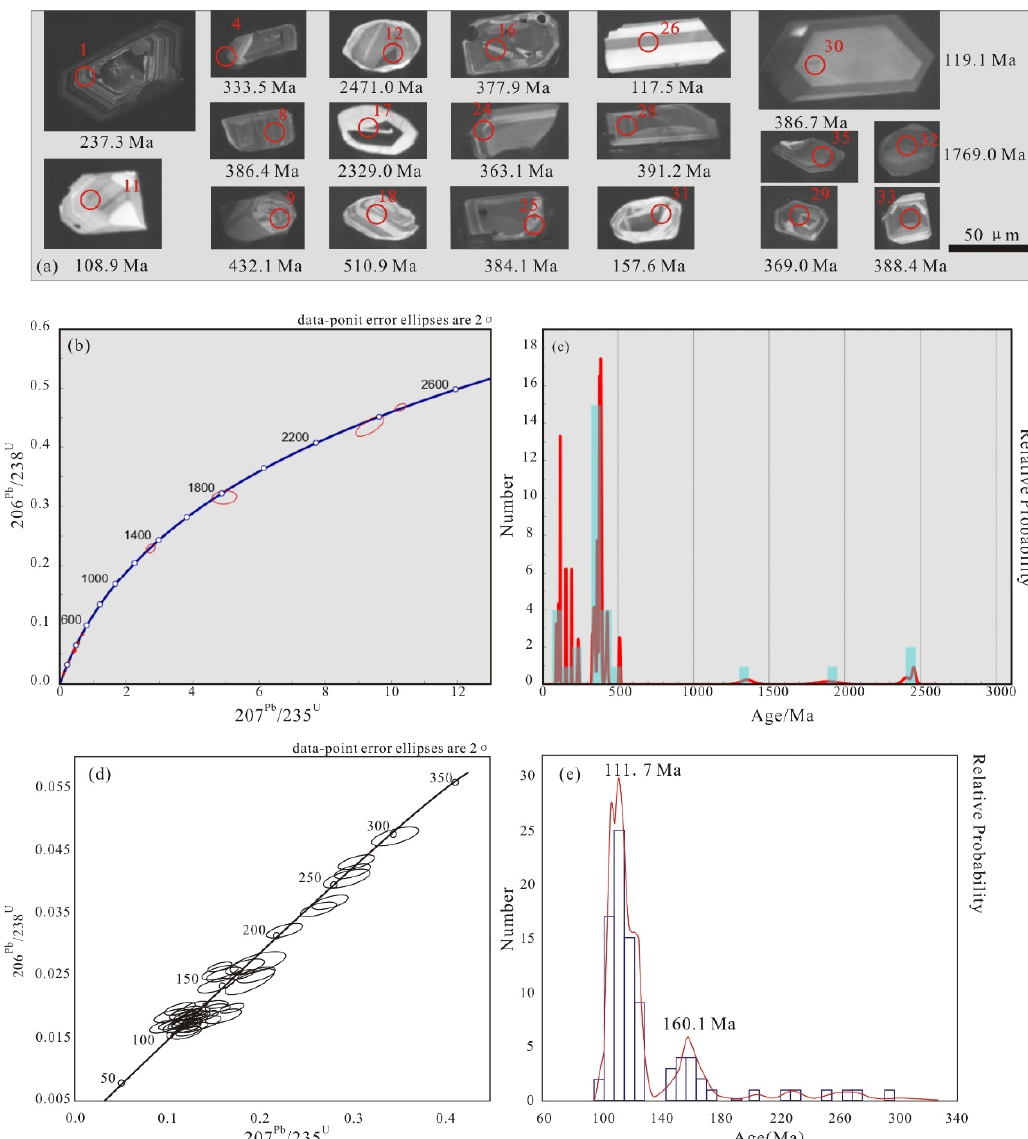
Figure 9. Zircon morphology and age spectrum of the volcanic eruptive rocks in the Jingzhushan Formation of Late Cretaceous from the Coqen Basin and the zircon age quoted in the Geji area [36]. ( a ) zircon morphology of eruptive rock; ( b ) harmonious ages of eruptive rock; ( c ) age spectrum of eruptive rock; ( d ) harmonious age of detrital zircon from Geji area; ( e ) age spectrum of detrital zircon in Geji area. Red and black circles represent the age aggregate region.